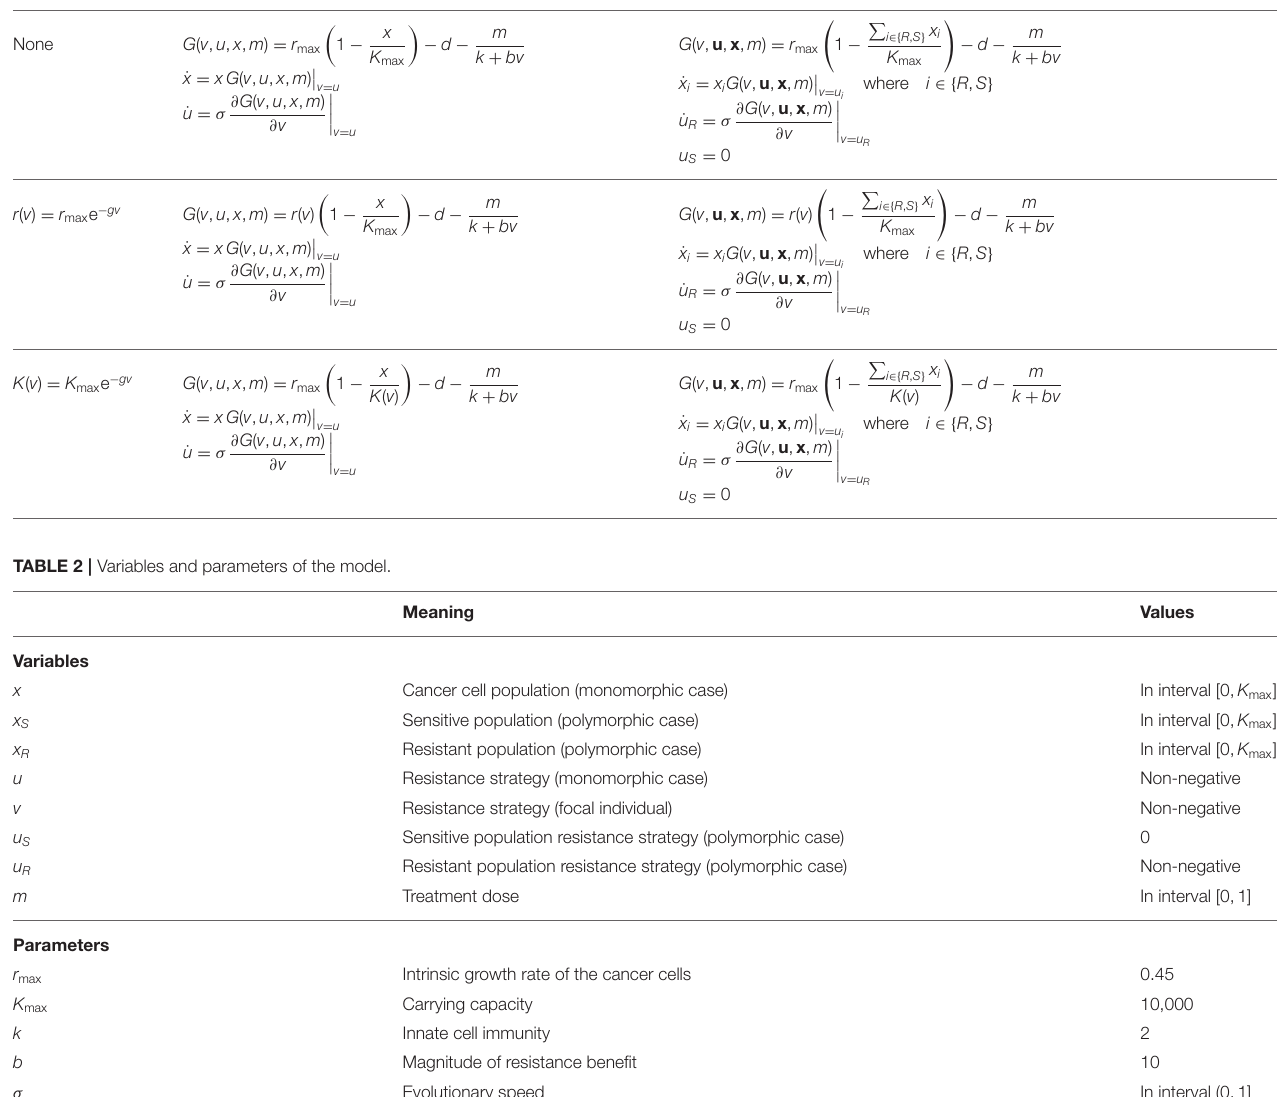
TABLE 1 | Different models analyzed in this paper: The first, second, and third lines of this table describe eco-evolutionary cancer dynamics with no cost of resistance, cost of resistance in the growth rate, and cost of resistance in the carrying capacity of cancer cells, respectively. Resistance